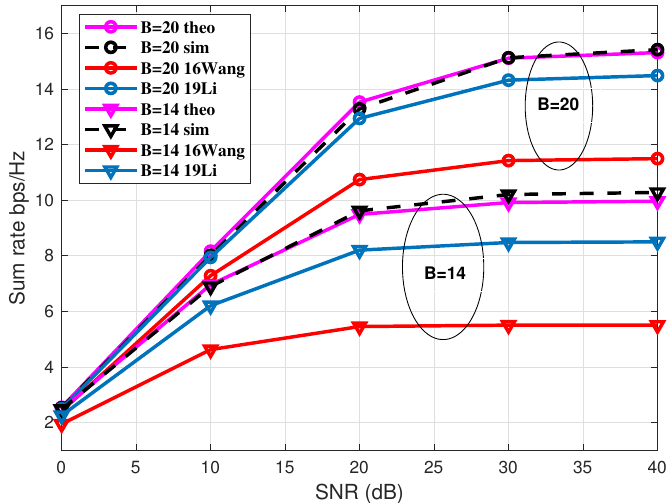
Figure 6. Theoretical sum-rate comparison of the proposed method and other rate-loss-based analysis methods with RVQ-based CSI feedback in ( 2 × 2,1 ) 3.